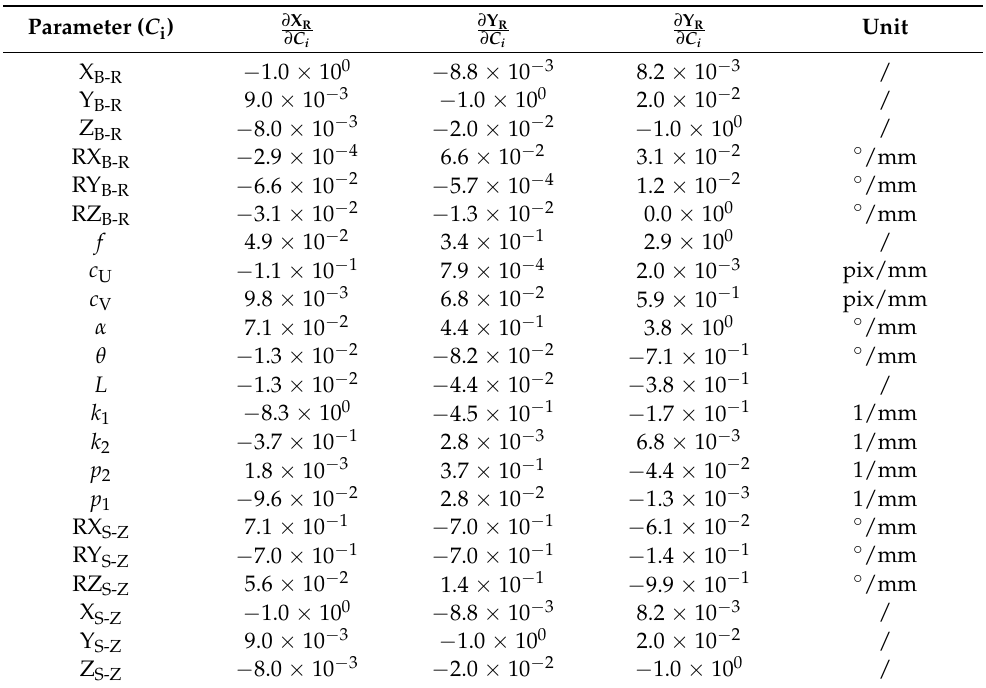
Table A2. Initial values of optimized transformation parameters, their weights and randomization